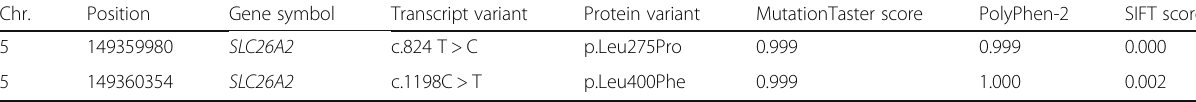
Table 1 Functional prediction of SLC26A2 mutations